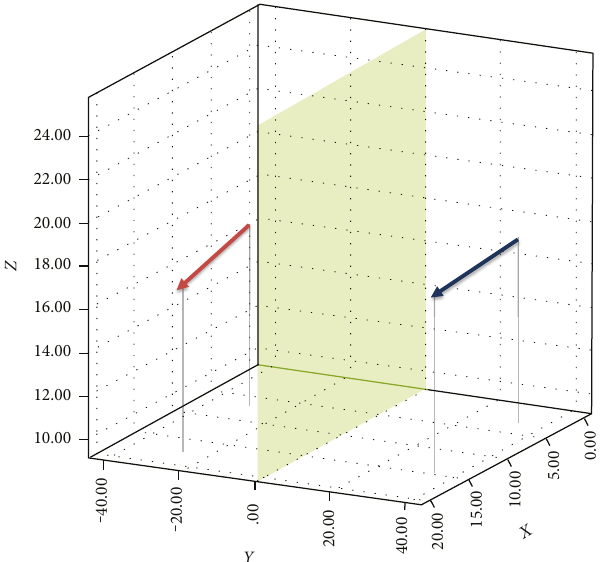
Figure 2: The eyeball vector diagram. The arrowhead represents point C, and the other point of the arrow represents point E. The red and blue arrows represent EC of the right and left eye, respectively, and it could be viewed and compared in the 3D coordinate system from di ff erent directions. Table 4: The coordinates and angles of the vector EC . The y and y of the left eyes were negative, and their absolute values were C E used. The positive values of arg M represent the ocular axis turned medial, and the negative represent turned outward. The positive values of arg F represent the ocular axis turned up, and the negative values represent the opposite. Both eyes Right eye Left eye 32.2